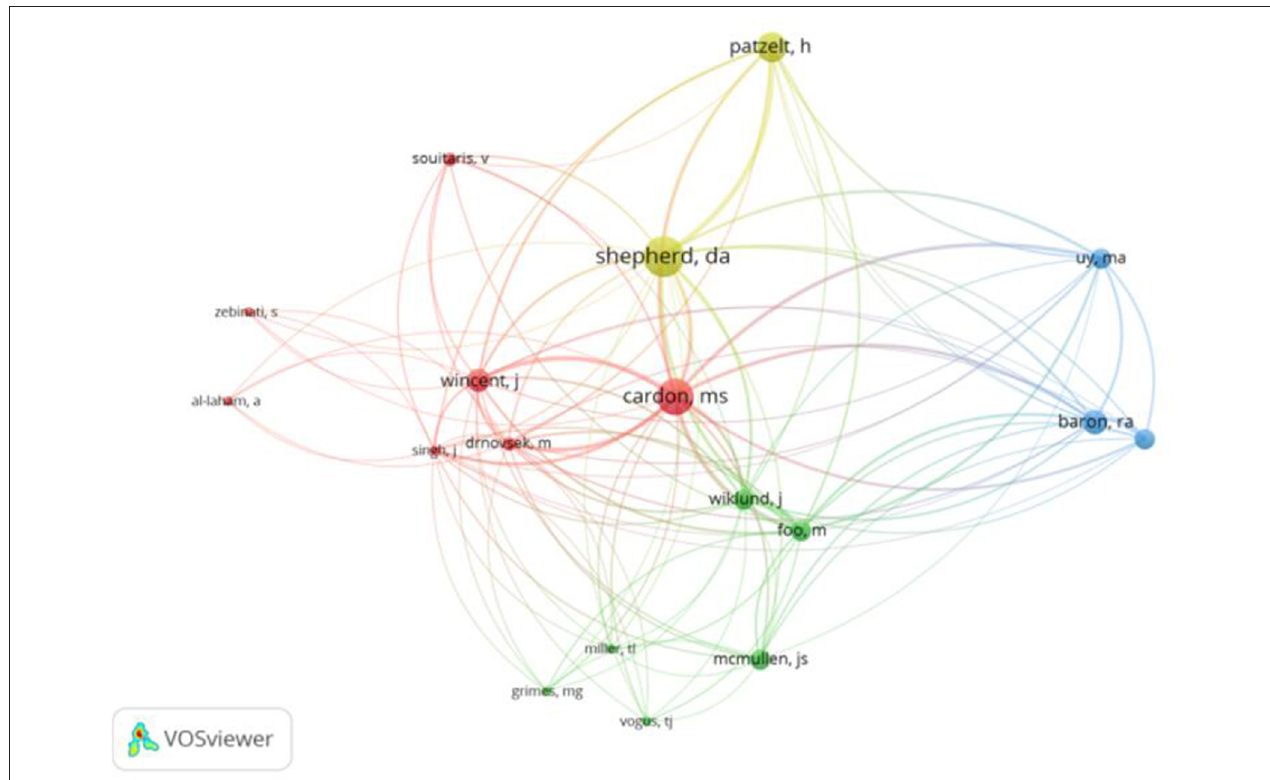
FIGURE 2 | Authors cooperation